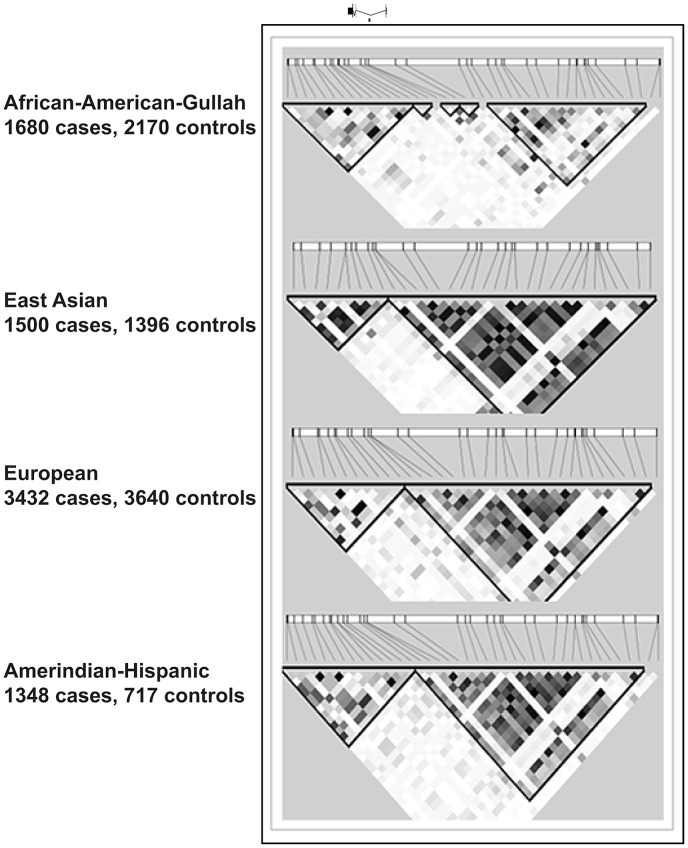
LD plots at TNFSF4 locus in four populations.This section of chromosome 1q25.1 encompasses the TNFSF4 gene and upstream region as defined by custom algorithm in Haploview 4.2. The measure of LD was used to depict 57 SNPs common to all cohorts, post QC and 1000 genomes imputation. The pair-wise correlations between TNFSF4 markers is illustrated in these plots by the correlation coefficient R2(where r2 = 0 = no correlation, white; 0<R2<1, gradations of grey; R2 = 1 = complete correlation, black). The TNFSF4 gene is positioned above the plots relative to haplotype blocks (black triangles) and grey ticks indicate SNP locations to scale.